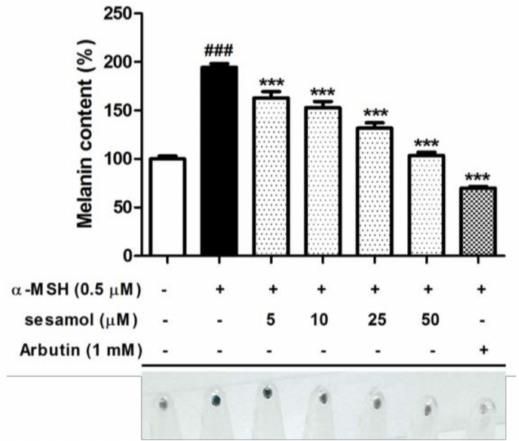
Figure 2. Melanin content (%) of B16F10 cells and cell pellets after 48 h of treatment with sesamol. Seasamol significantly inhibited melanin synthesis. Each value is presented as the mean ± SD. Significant difference versus control: ### p < 0.001. Significant difference versus α -MSH-treated group: *** p < 0.001. Positive control: 1 mM